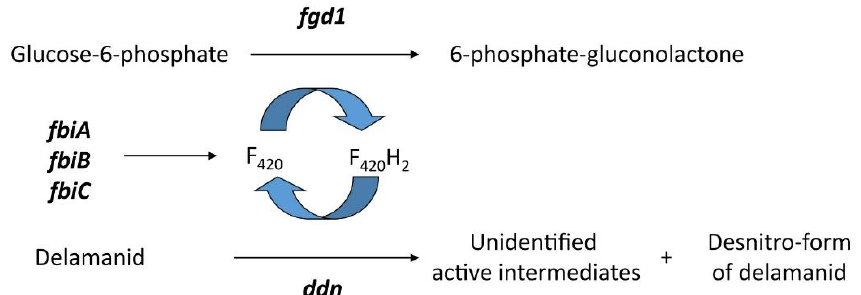
Figure 6. Gene products involved in the bioactivation of delamanid [86].